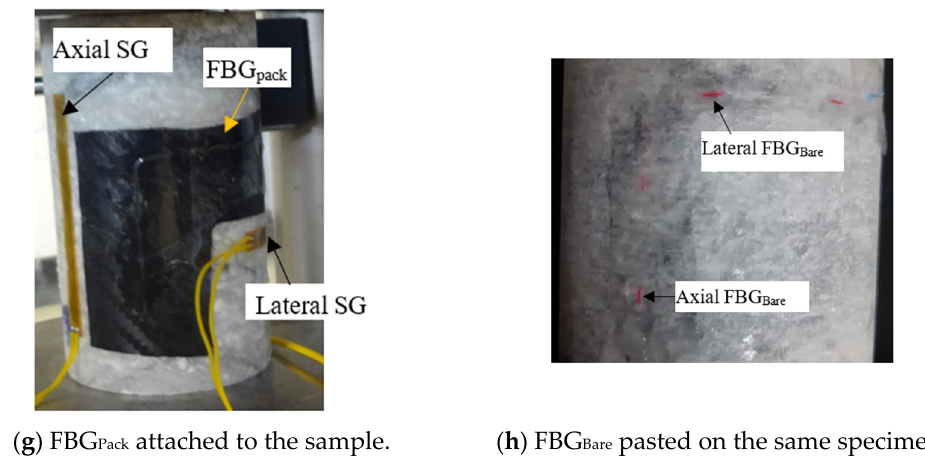
Figure 4. The process of packaging and pasting of both FBG pack and FBG Bare on limestone rock .